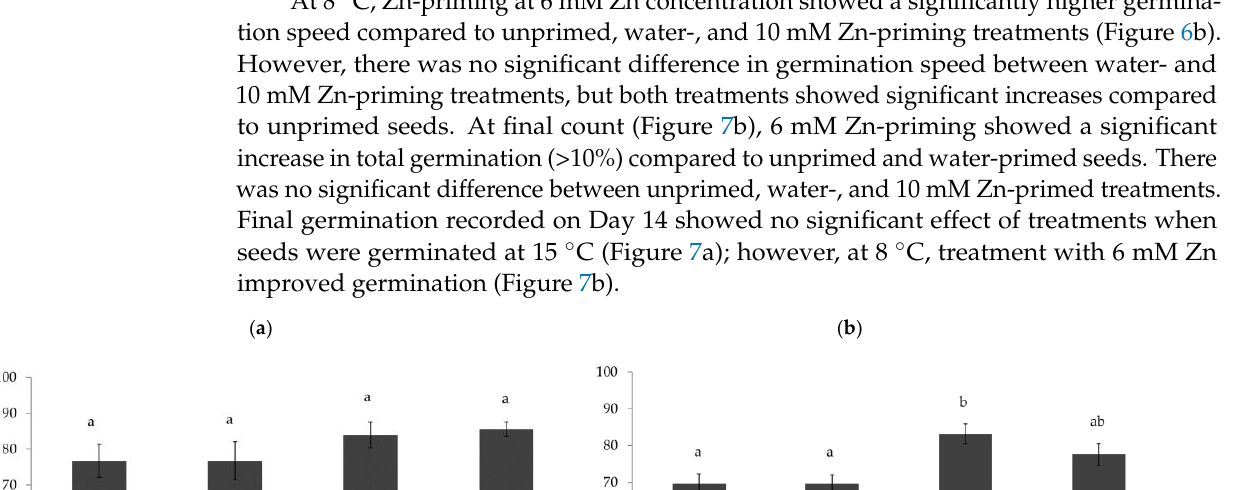
Figure 6. Germination speed of control, water-, 6 mM, and 10 mM Zn-primed spinach seeds germinated at 15 °C ( a ) and 8 °C ( b ) in Petri dishes. Germination was monitored daily up to 7 days after sowing. Data presented are the means of four replicates (25 seeds in each replicate) with standard errors.